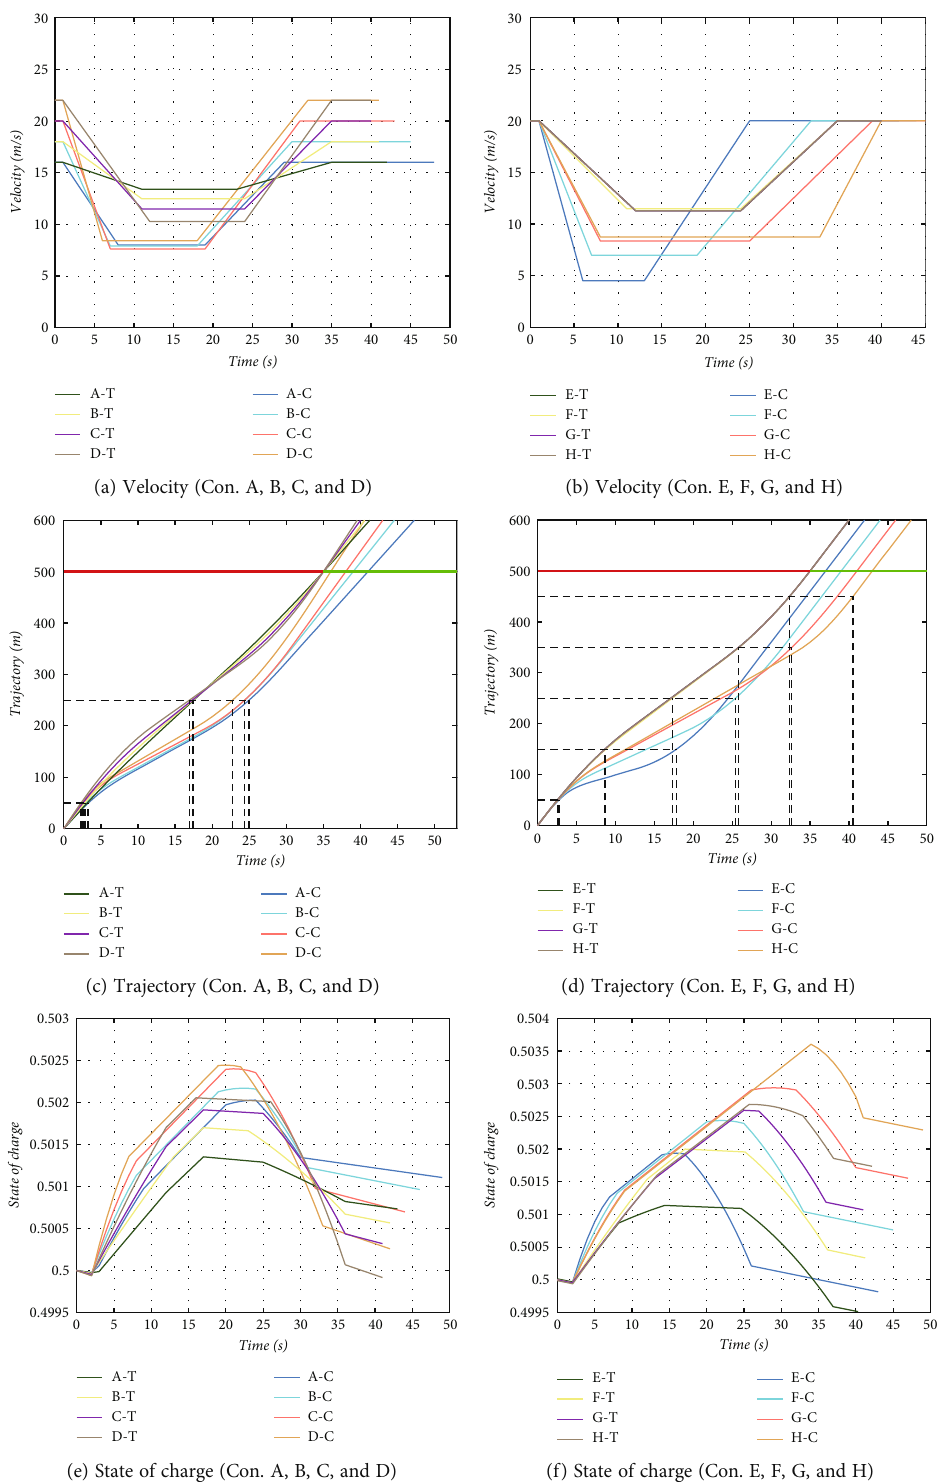
Figure 3: Results of eight